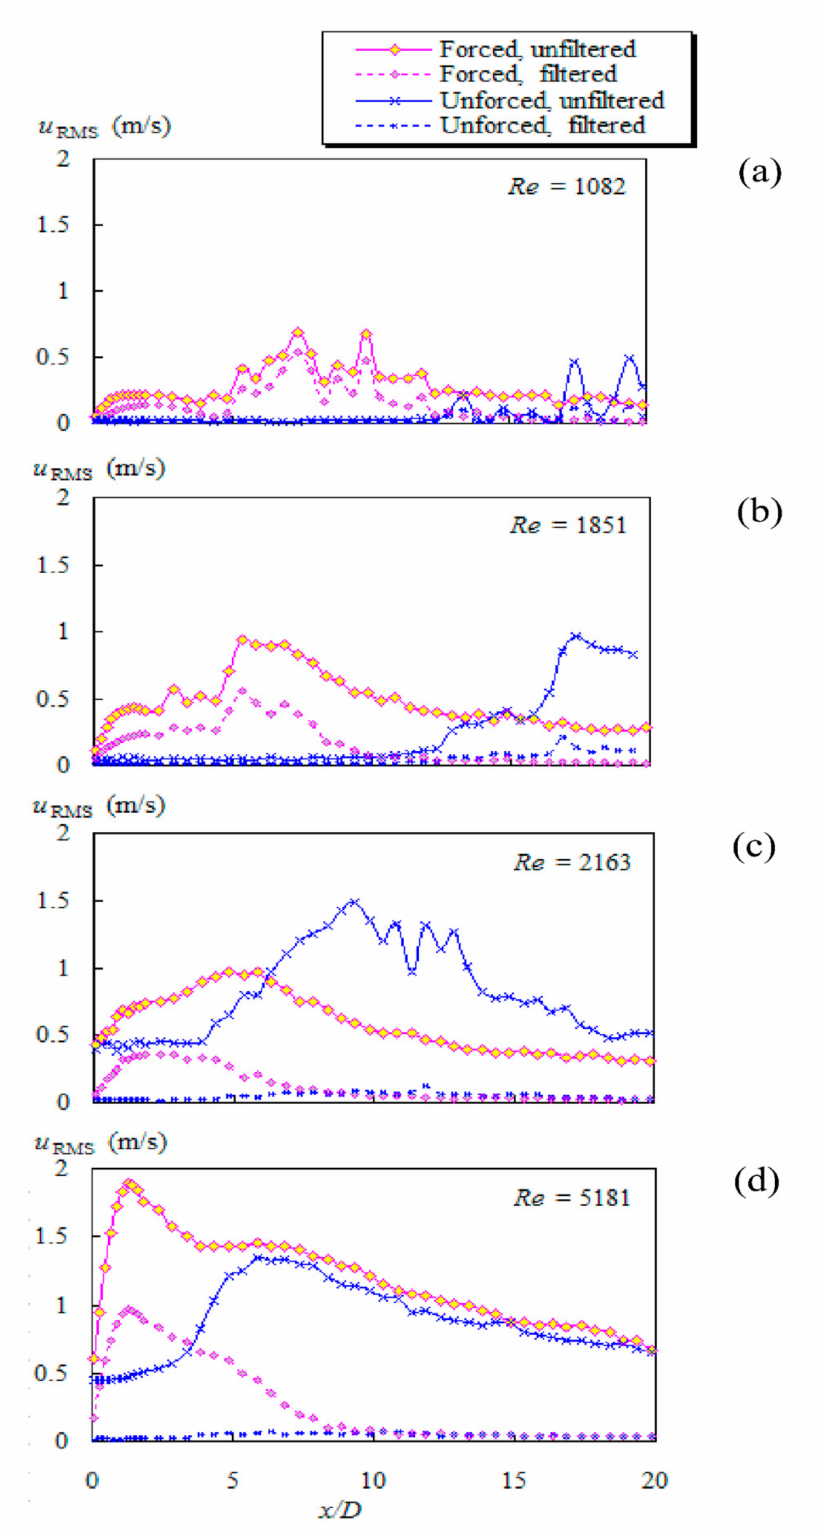
Figure 10. Comparison of filtered and unfiltered profiles of the velocity fluctuations: ( a ) Re = 1082; ( b ) Re = 1851; ( c ) Re = 2163; ( d ) Re =